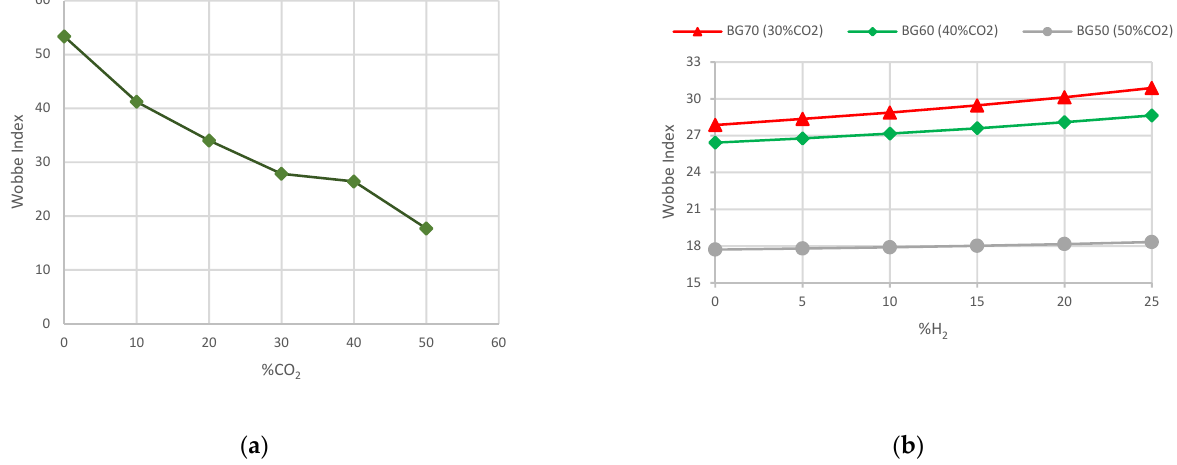
Figure 4. Wobbe Index analysis of biogas and biogas–hydrogen mixtures: ( a ) influence of CO 2 addition to natural gas Wobbe Index; ( b ) influence of hydrogen addition to Wobbe Index.